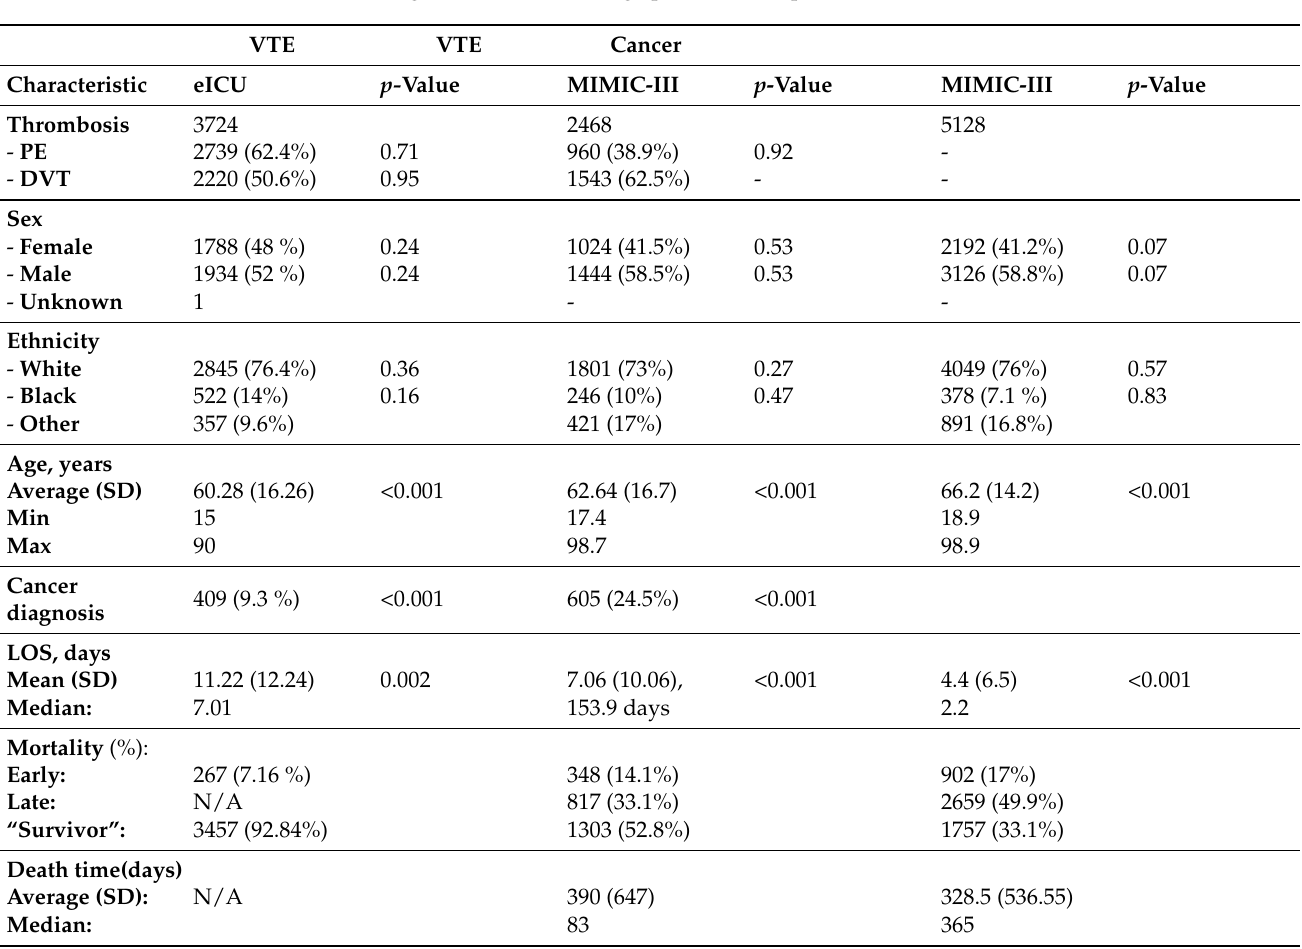
Table 1. Demographic and clinical characteristics of patients with VTE or cancer from eICU and MIMIC-III databases. SD denotes the standard deviation, and LOS length of stay. p -Values between “surviving” and “non-surviving” patients are